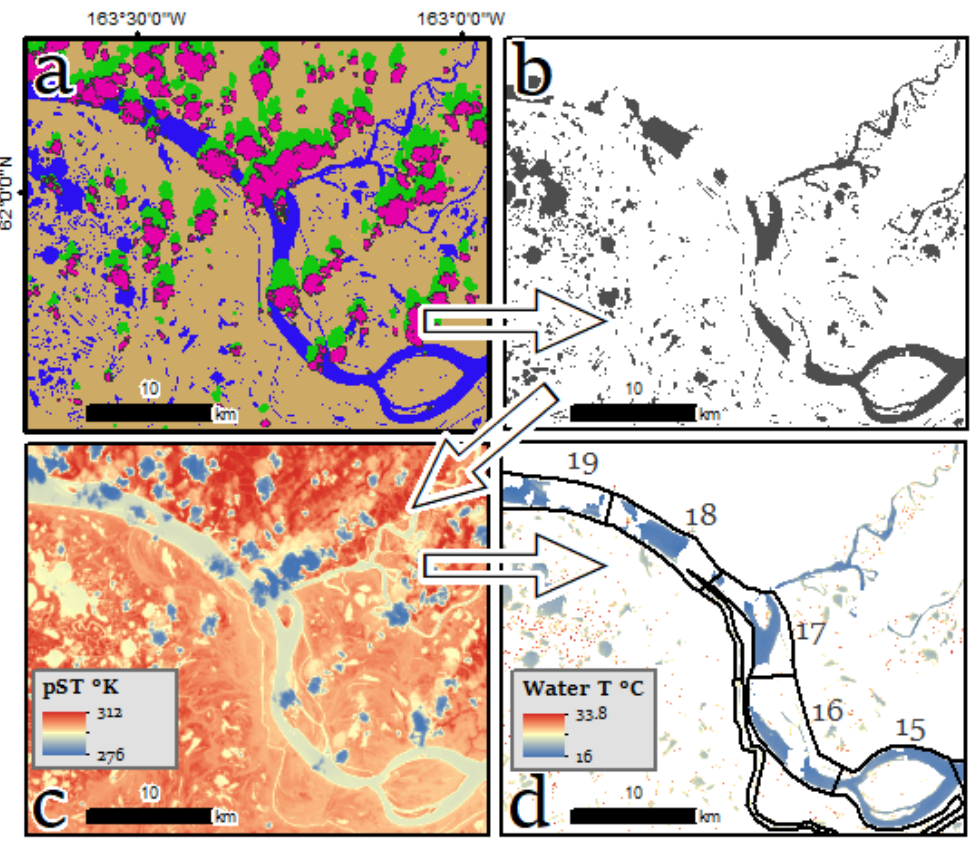
Figure 2. ( a ) PIXELQA raster qualifying land-low probability clouds (brown), water low probability clouds (blue), clouds (magenta), and cloud shadow (chartreuse). ( b ) Masking raster where water low probability cloud pixels are reclassified to a value of 1 and all else is null. ( c ) The surface temperature (ST) raster with blues depicting low temperatures surfaces and red depicting high temperatures. ( d ) ST raster after masking by water surface raster with zones of interest shown (black bounding lines).